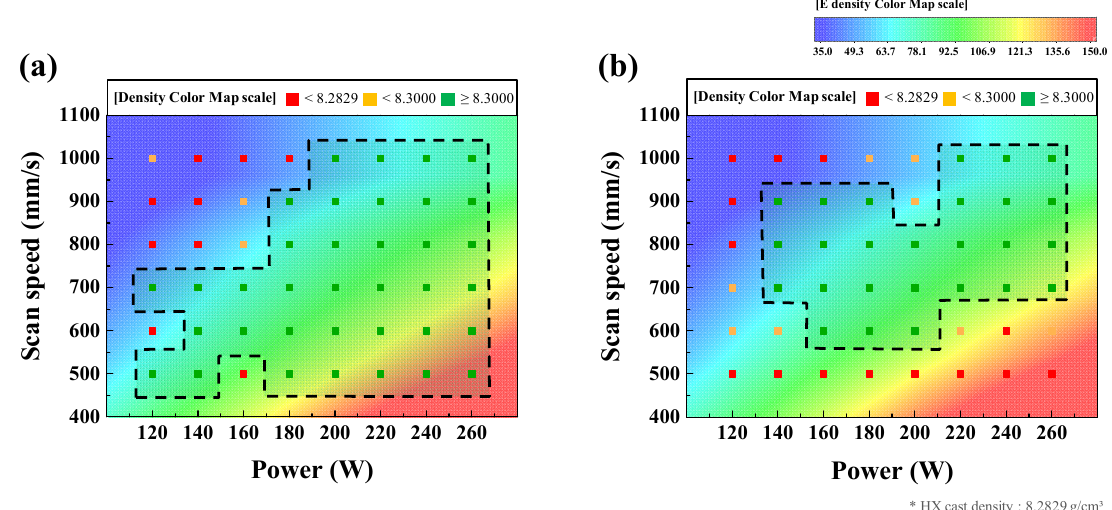
Figure 4. Process window map for ( a ) Powder I specimens and ( b ) Powder II specimens fabricated at laser powers of 120–260 W in increments of 20 W, and scan speeds of 500–1000 mm/s in increments of 100 mm/s. Red points indicate specimens with a density lower than that of Hastelloy X cast, yellow points indicate specimens with a density higher than that of Hastelloy X cast but less than 8.3000 g/cm 3 , and green points indicate specimens with a higher density than 8.3000 g/cm 3 .